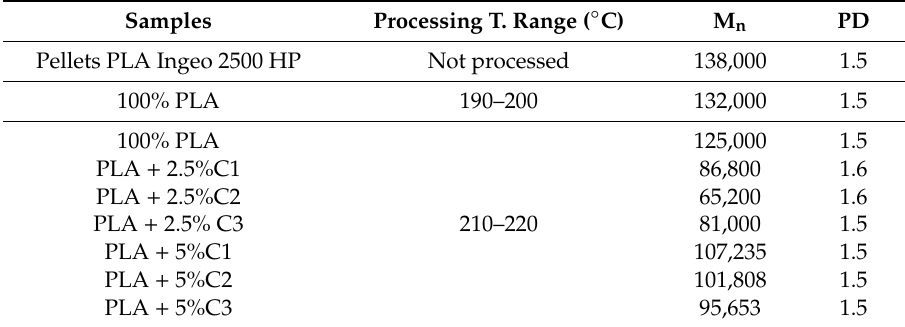
Table 1. Molecular weight and polydispersity of PLA and PLA / compatibilizer mixtures at di ff erent processing temperature ranges. Mn is the molecular weight and PD is the